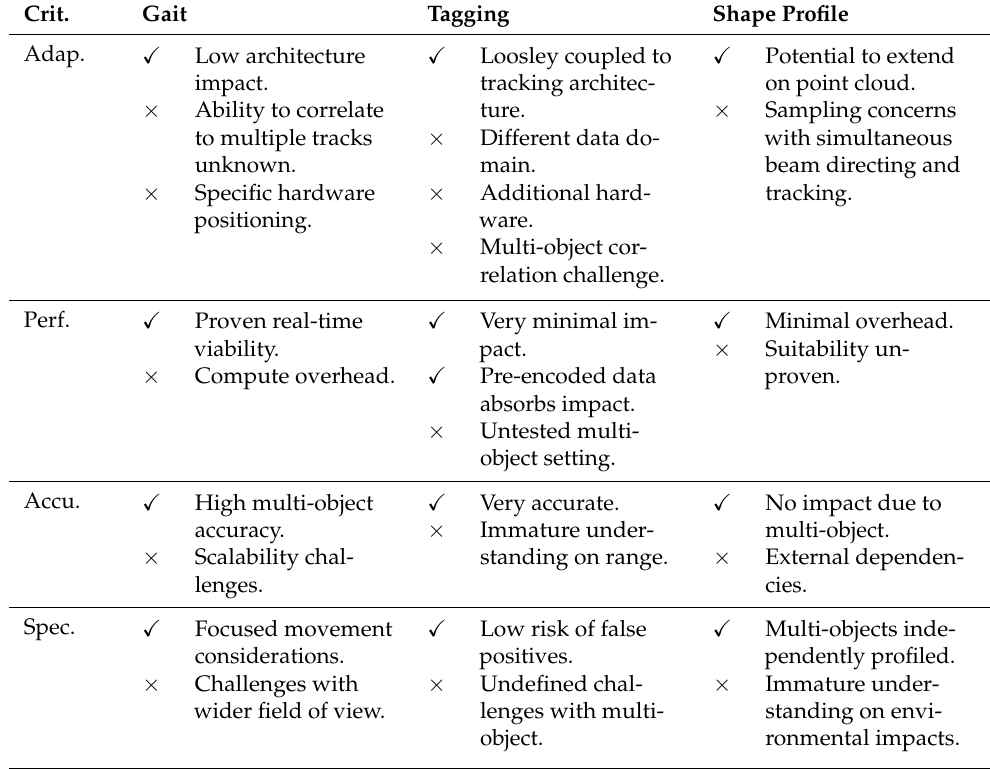
Table 3. A comparison of identification methodologies explored for the enhancement of tracking objects discontinuously in a mmWave tracking